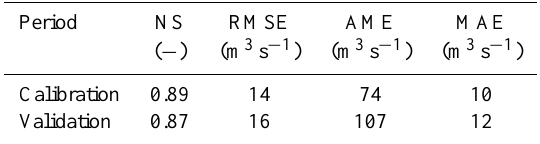
Table 6. NS, RMSE, AME and MAE values for the calibration of the flood routing model.